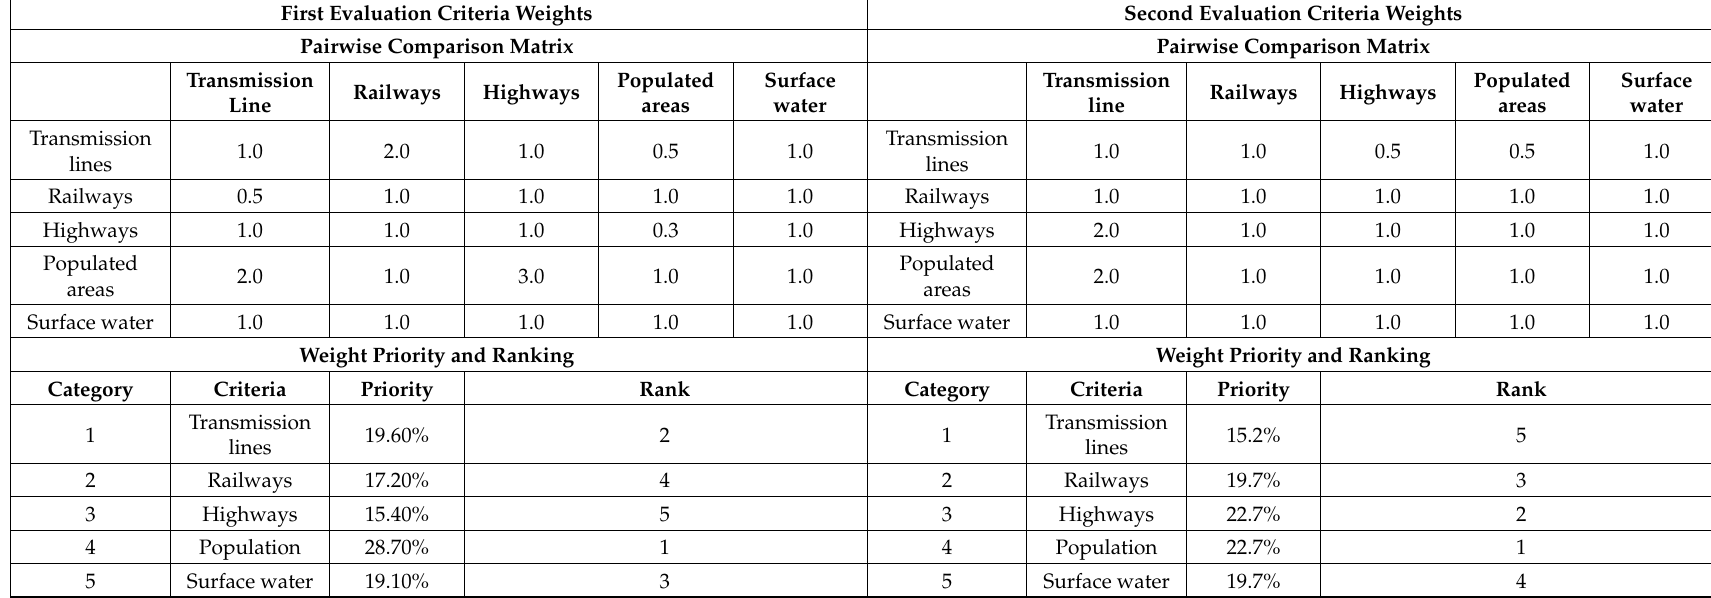
Table 9. Sample criteria weights and